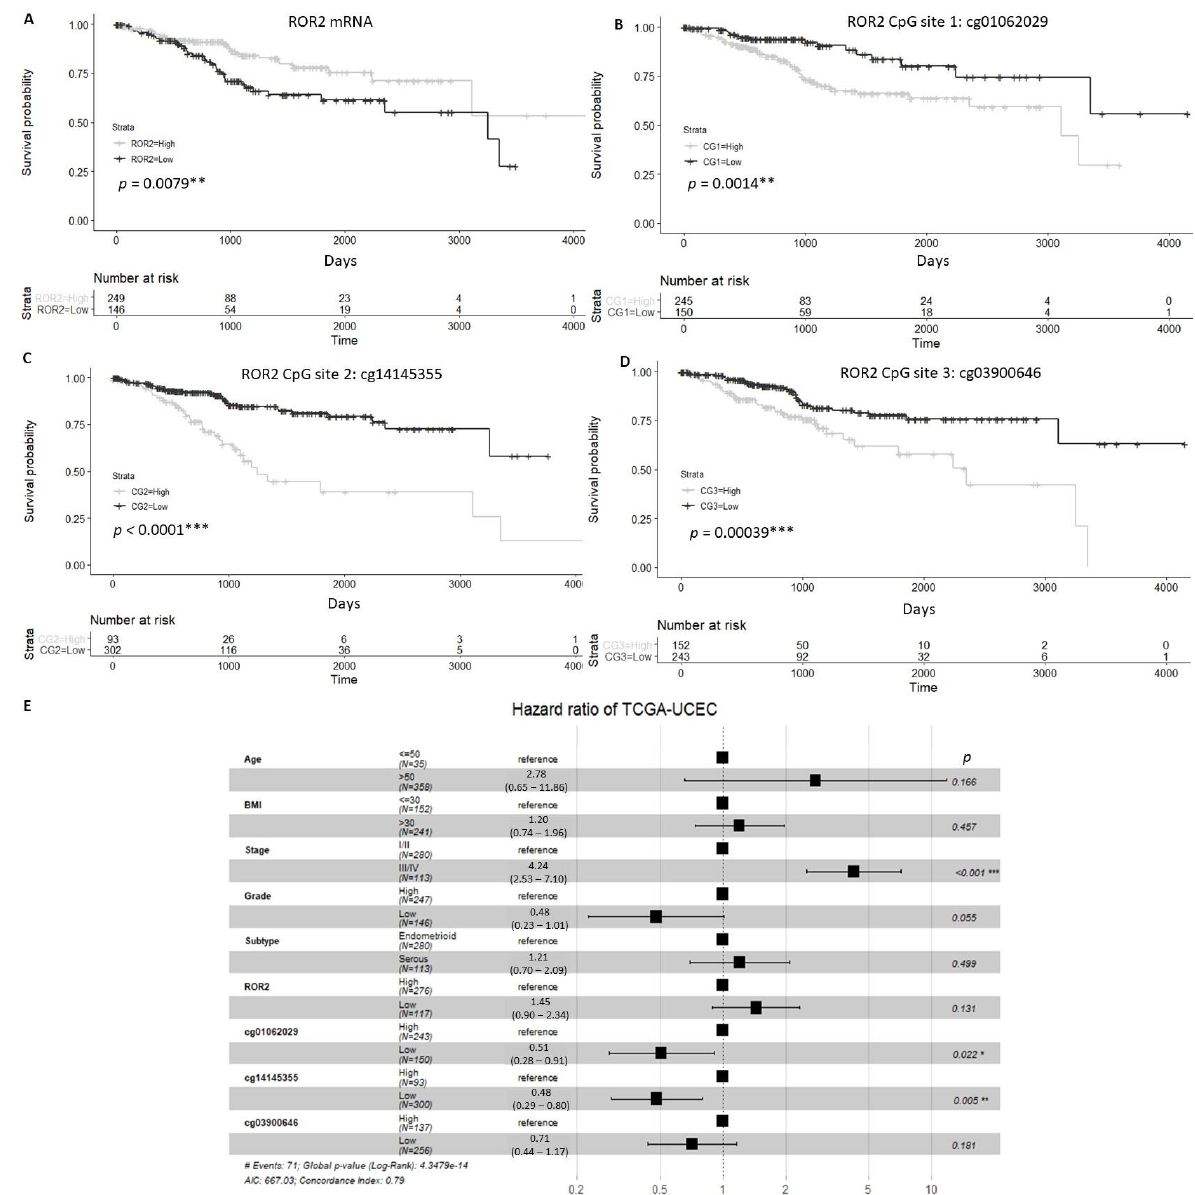
Figure 1. Univariate and multivariable overall survival analysis of TCGA-UCEC cohort patients. ( A ). Patients with low ROR2 expression showed significantly worse overall survival (OS) compared to those with high ROR2 expression. ( B – D ). High methylation levels of three CpG sites (CG1-cg01062029, CG2-cg14145355, CG3-cg03900646) located on the ROR2 promoter were associated with worse OS significantly ( p = 0.001, p < 0.001, p < 0.001 respectively) ( E ). Forest plot of Cox regression result incorporated age, BMI, stage, grade, subtype, expression and methylation of ROR2 on OS. * Significant